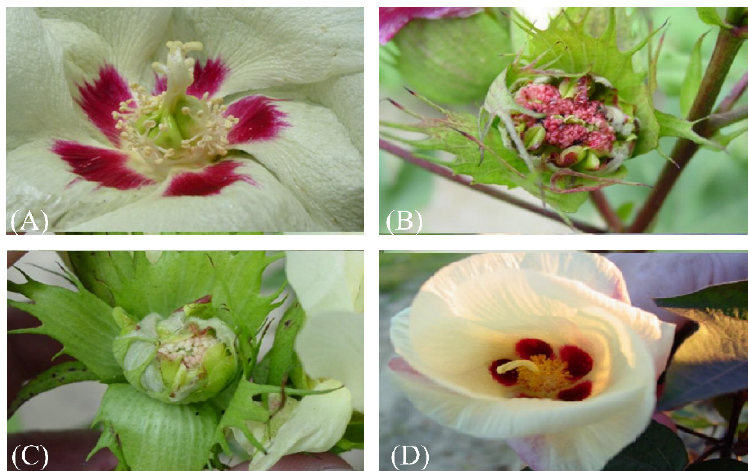
Figure 2. Floral abnormality in later generation hybrids between Gossypium hirsutum and G. barbadense : ( A ) abnormal style, stigma, and anther formation; ( B , C ) abnormal bud development; and ( D ) an abnormal flower of an F2 generation of Gossypium hirsutum × G. barbadense